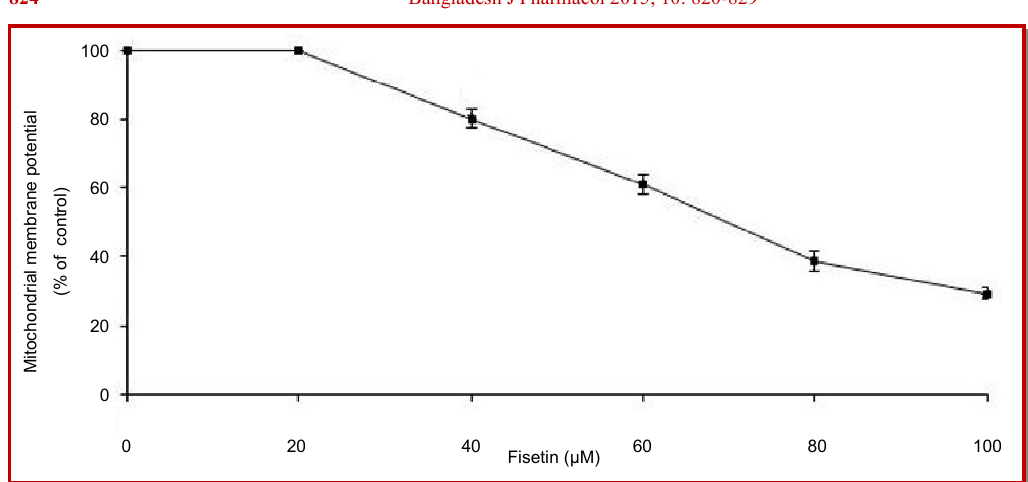
Figure 4: Effect of fisetin on the mitochondrial membrane potential of U-2 OS cells Values are represented as mean ± SD; n=3; *represents p<0.05 compared with control as determined by one way-ANOVA